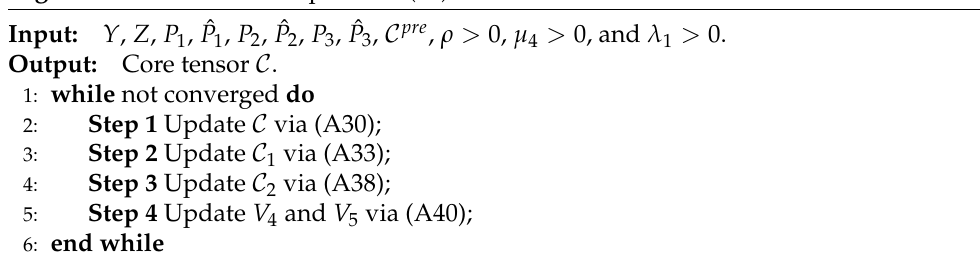
Algorithm A4 Solve C - Subproblem (19) with